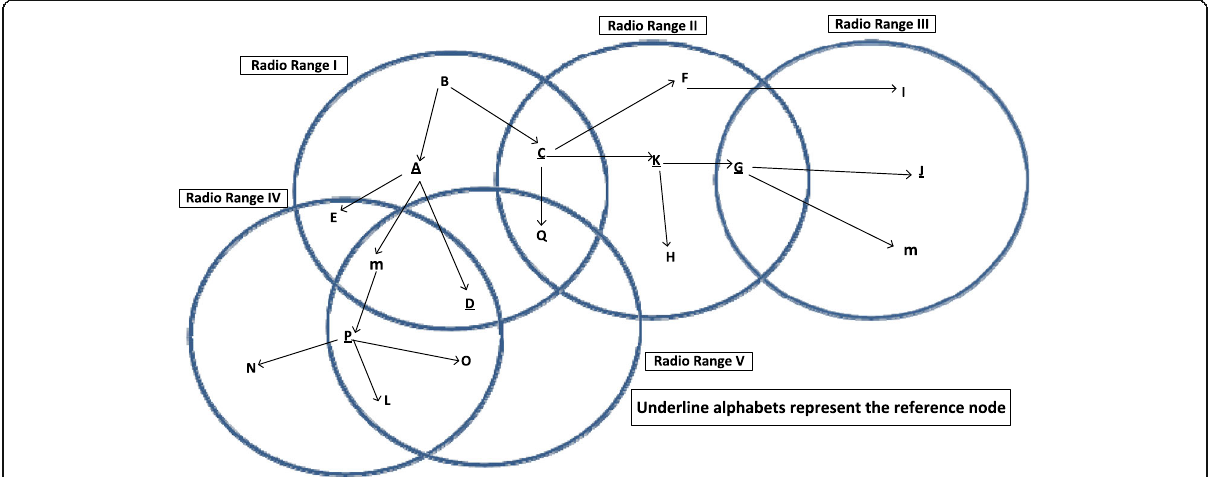
Fig. 8 Connected graph of spoofing in different radio ranges. Shows the radio ranges of the global detection. The participating mobile nodes are A, B, C, D, E, F, G, H, I, J, K, L, M, N, O, P and Q, which are divided in the five different radio ranges of I, II, III, IV and V. The underlined letters represent the reference